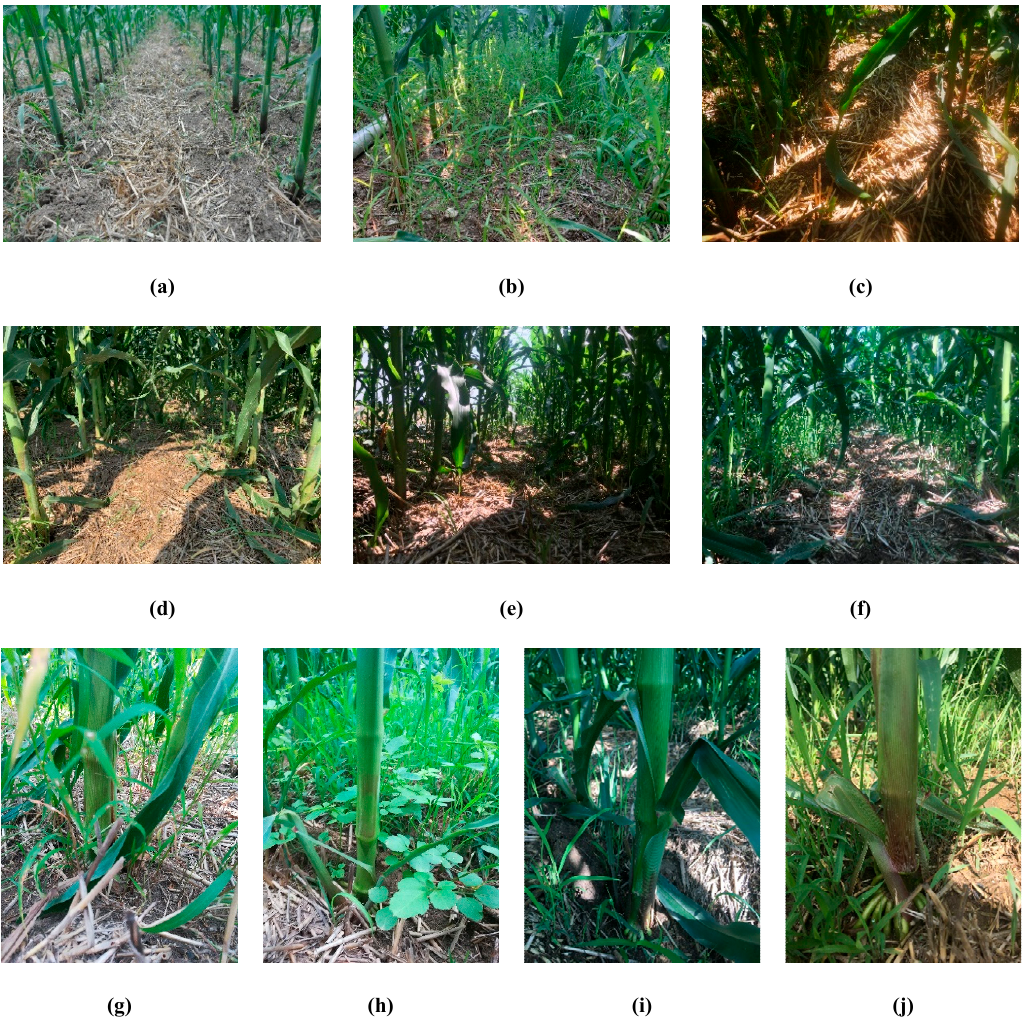
Figure 3. Sample images in different environments. (a) Ideal environment; (b) Excessive weeds; (c) Insufficient illumination; (d) Disordered branches and leaves; (e) Branches, leaves and light effects; (f) Weeds, branches and leaves are covered, and the light is insufficient; (g) Branches and leaves; (h) Weeds; (i) Branches and leaves block light; (j) Branches, leaves and weeds cover the rhizome.